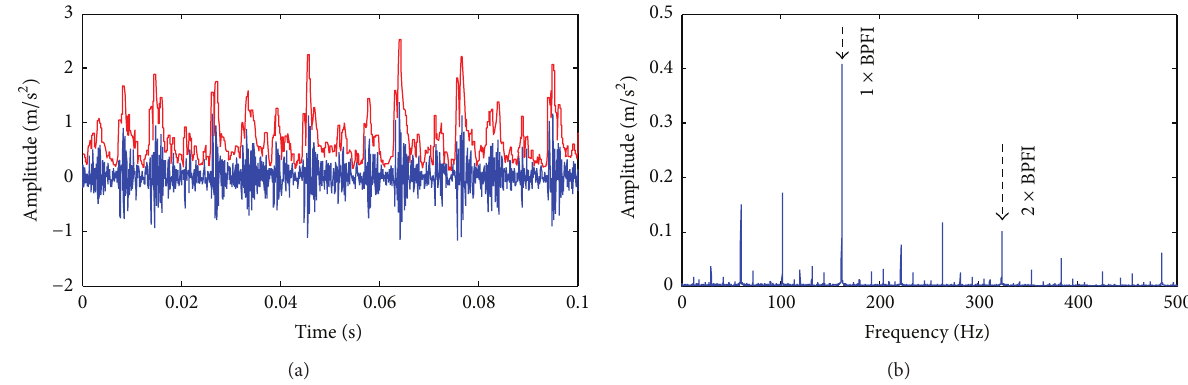
Figure 11: (a) Results of morphological operation dilation-erosion gradient; (b) frequency spectrum of